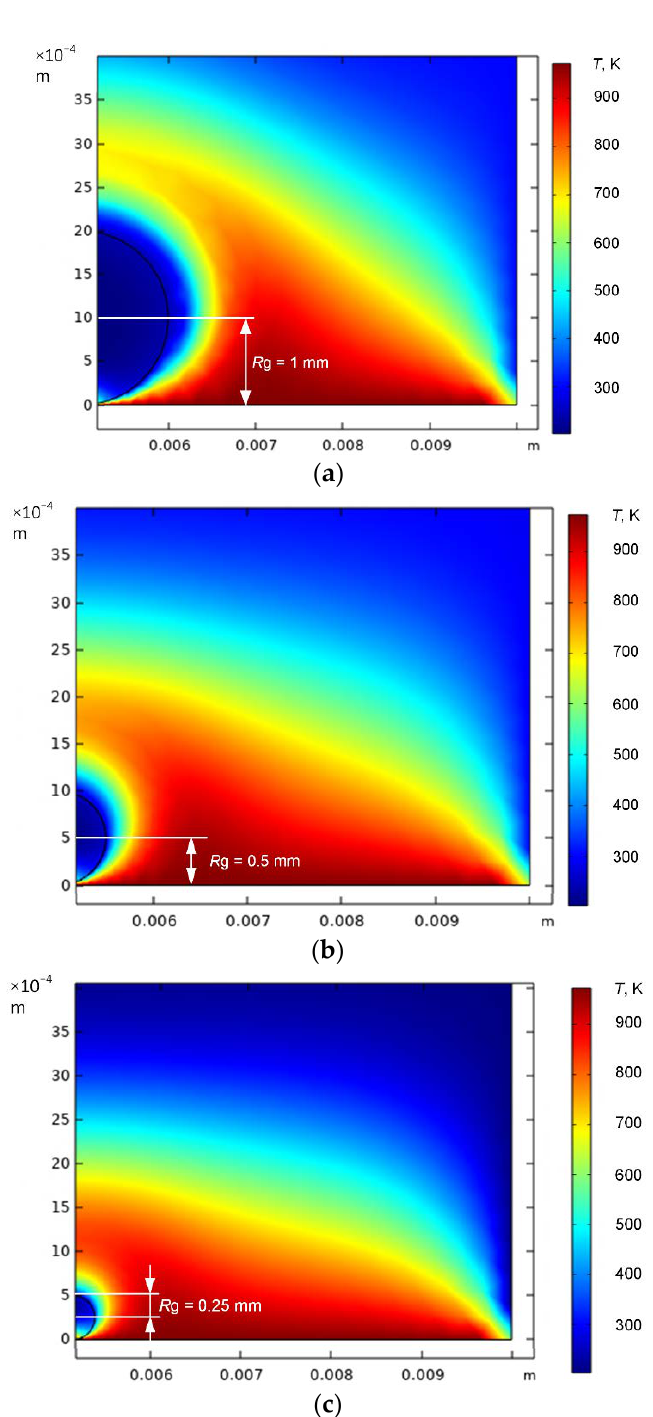
Figure 4. The temperature fields of the gas hydrate ignition area under the conditions of conductive heating when varying the typical size of a gas hydrate particle at a substrate temperature of 973 K: ( a ) R g = 0.25 mm, ( b ) R g = 0.5 mm, ( c ) R g = 1 mm.